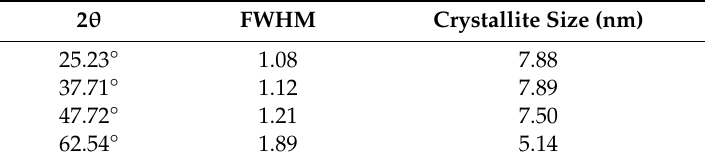
Table 1. Crystallite size of TiO 2 nanoparticles calculated by Debye–Scherrer method.